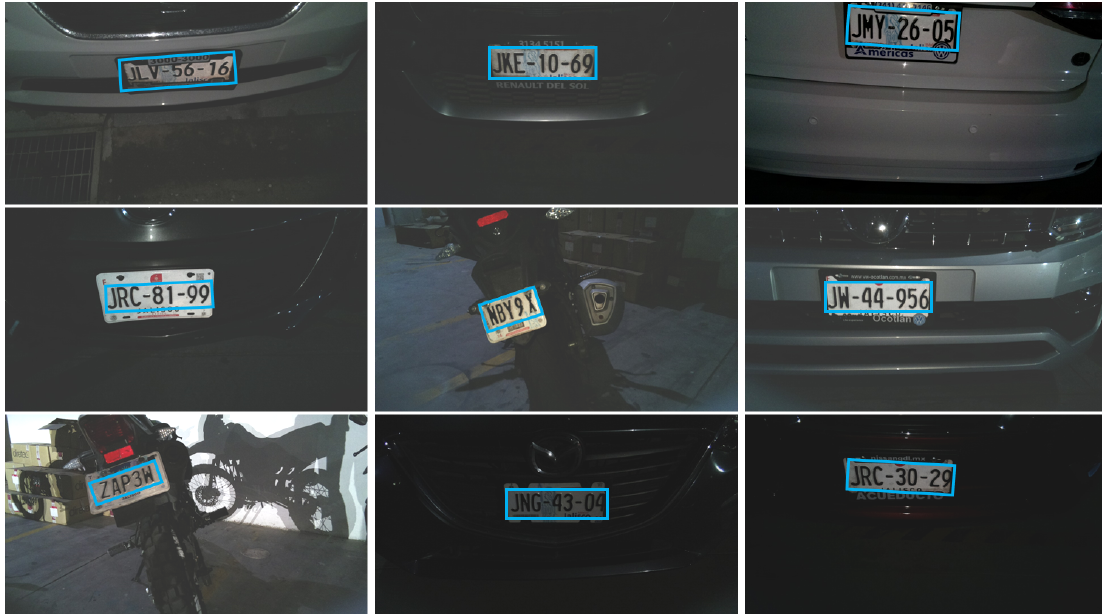
Figure 21. License plate identification results for different environmental